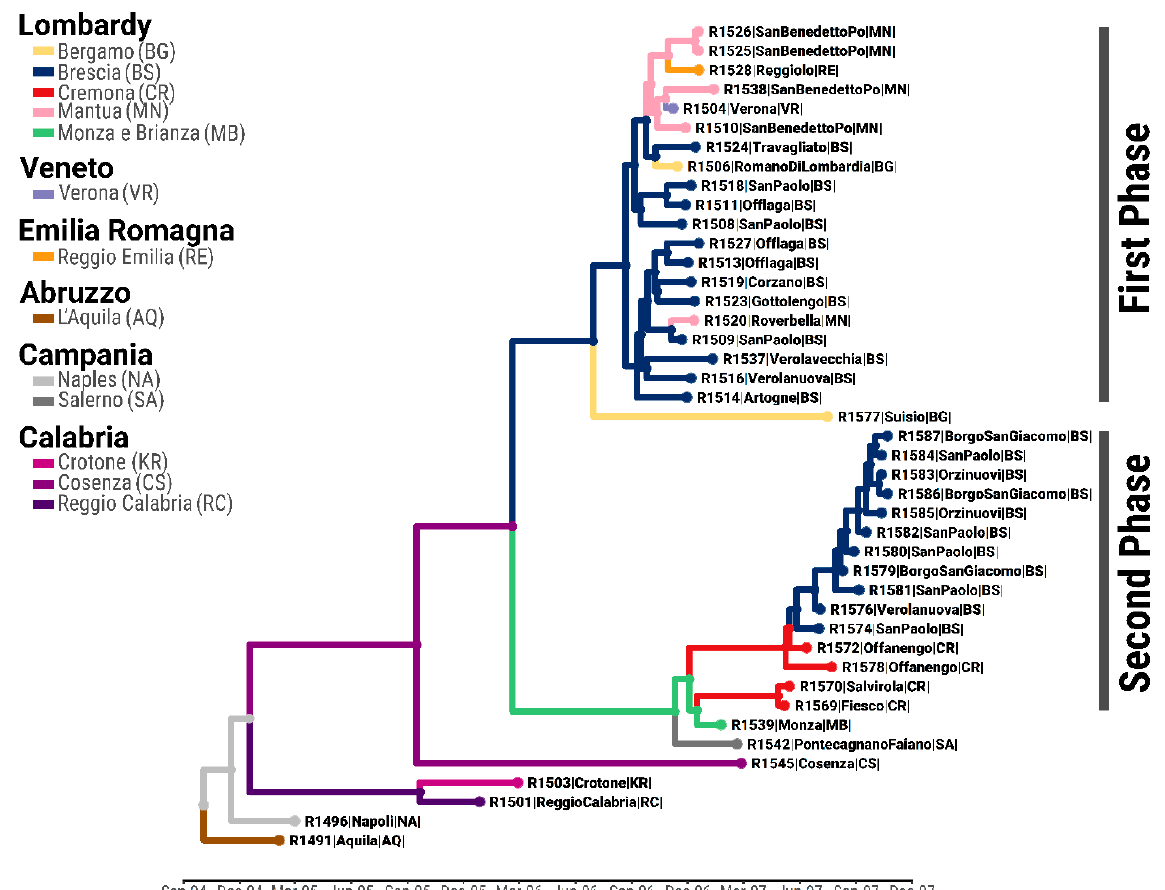
Figure 2. Phylogeographic history of the 2006–2007 SVD epidemic in northern Italy reconstructed from the 43 full-length SVDV genome sequences. Branches and tips are coloured according to the posterior geographical ancestry resulting from the Bayesian discrete asymmetric trait analysis with the province inputted as a discrete trait.